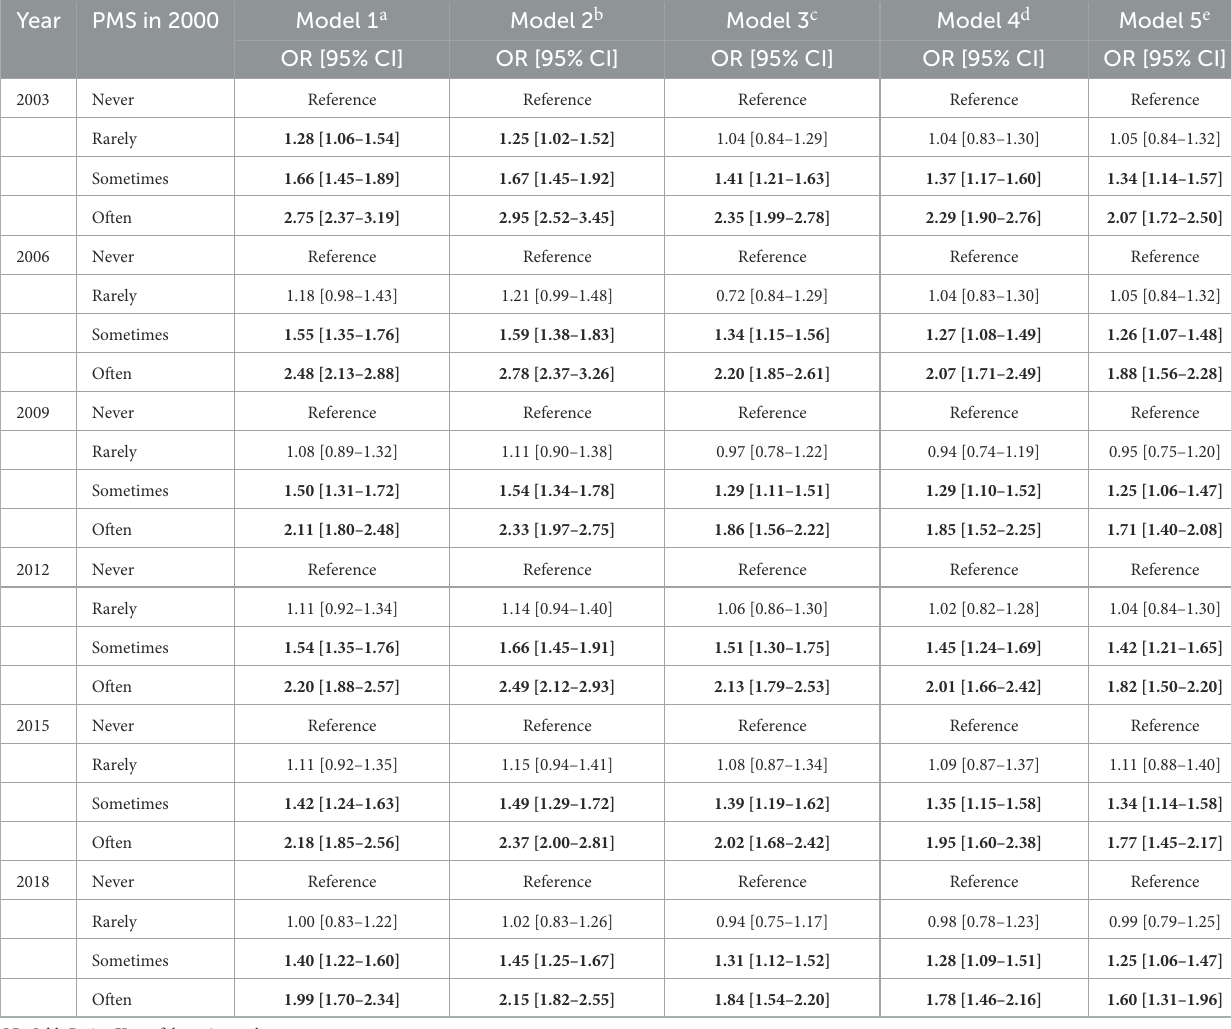
TABLE 4 Adjusted and unadjusted models for the association between self-reported frequency of PMS symptoms in 2000 and self-reported frequency of depressive symptoms at each follow-up